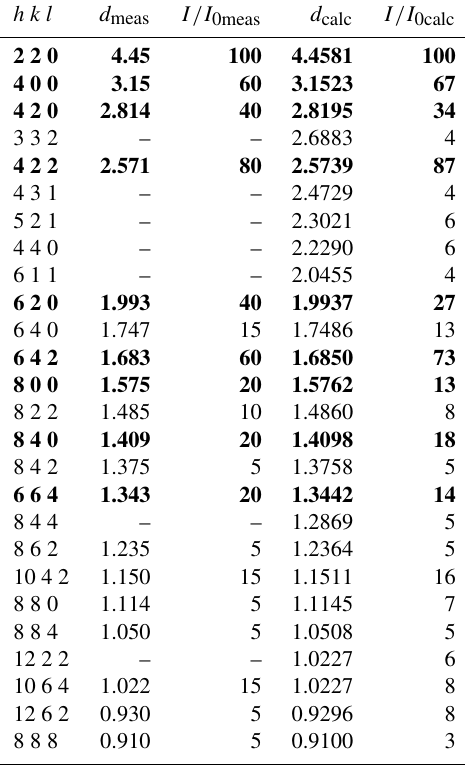
Note: calculated diffraction pattern obtained with the atomic parameters reported in Table 5 (only reflections with I/I 0calc ≥ 3 are